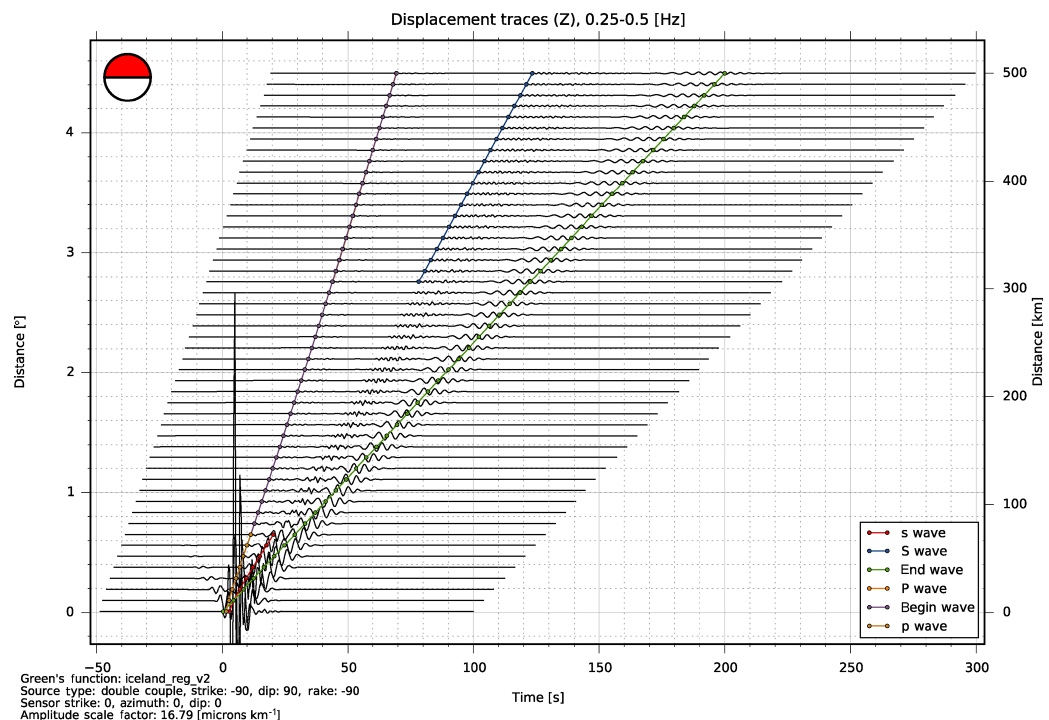
Figure 4. Synthetic seismogram distance section generated by the report sub-command of fomosto (generated by command fomosto report single min_config wherein min_config is a configuration file). Vertical component seismograms are calculated for a given moment tensor source for a given frequency range and distance range provided in the GF store (0.25–0.5Hz at 0–500km of distance). Theoretical first arrivals (P body waves) and other travel time curves are plotted together with synthetic seismograms. Such a display is useful to identify numerical artefacts. Here, an acausal numerical phase running with a negative velocity into negative times at distances below 50km can be